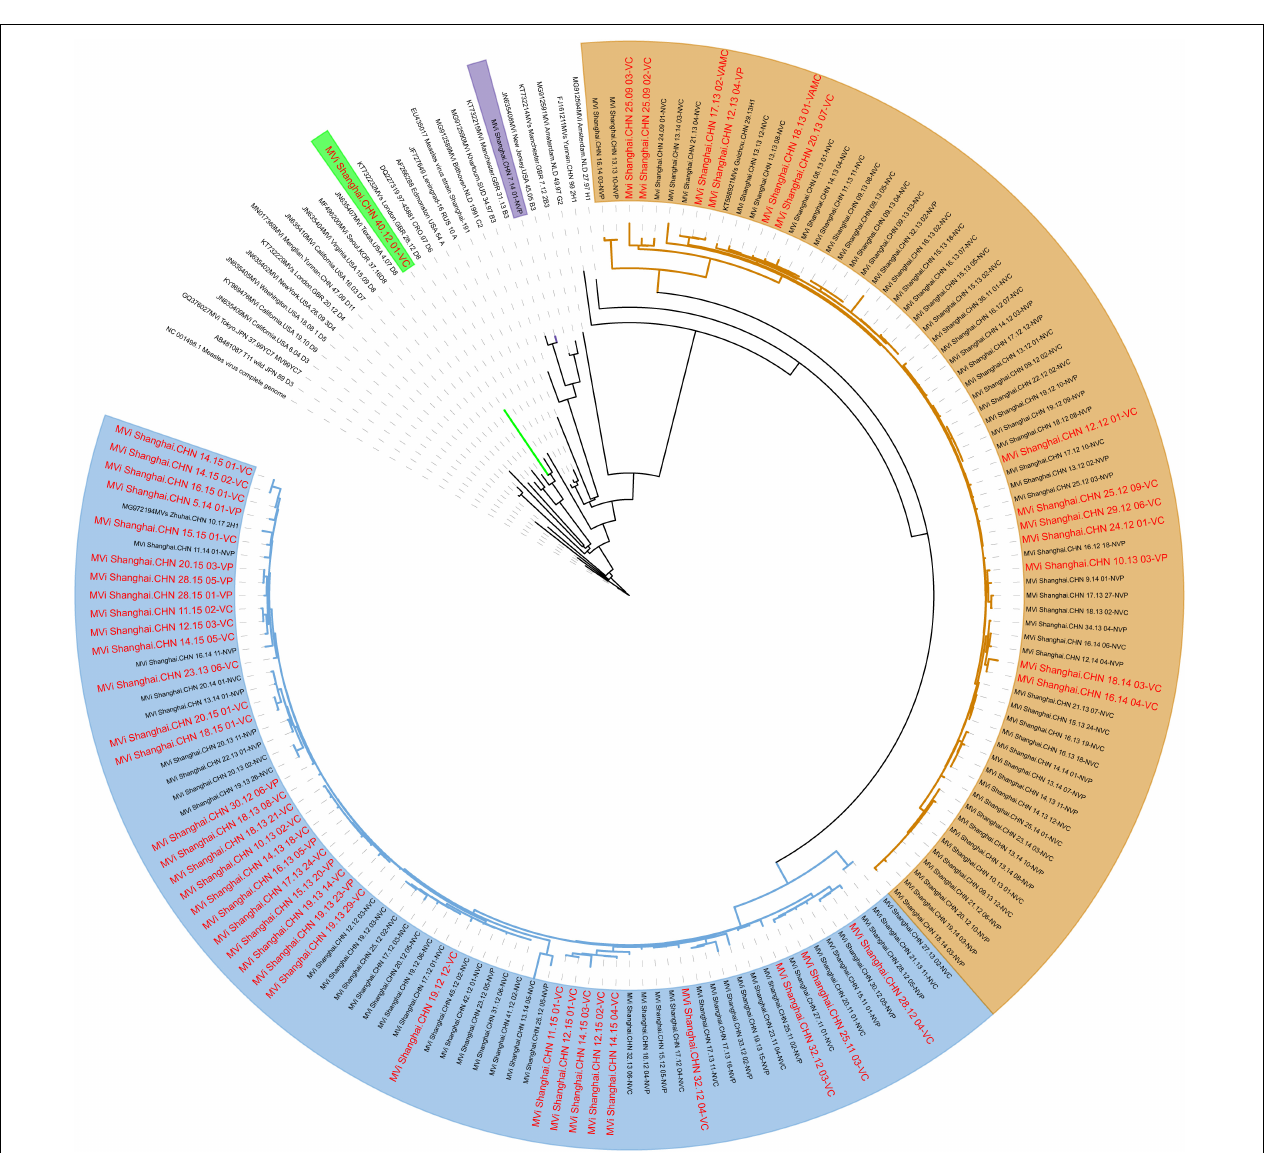
FIGURE 3 | Maximum clade credibility tree of 147 Shanghai and global MV isolates derived using the whole genome. The D8, B3, and H1-A, H1-B are highlighted using green, purples, yellows, and blues, respectively.